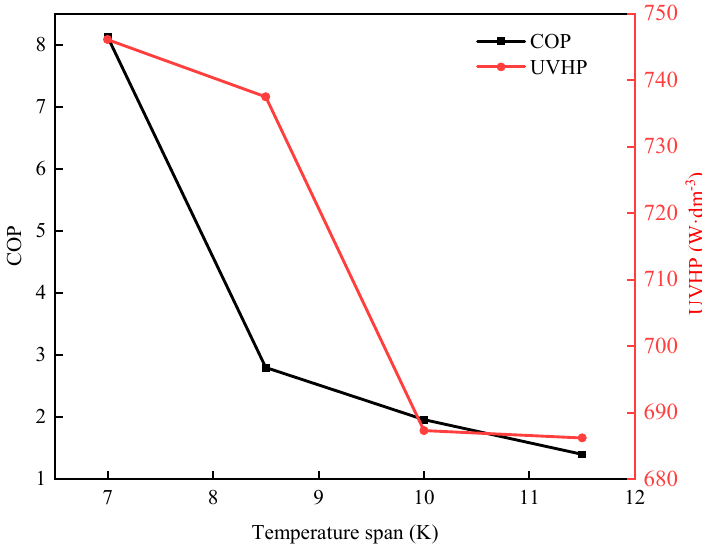
Figure 9. COP and UVHP at different temperature spans. When the temperature span successively increases from 7 K to 11.5 K, the UVHP decreases by 1.16%, 6.8%, and 0.17%, respectively, while COP decreases most when the temperature span changes from 7 K to 8.5 K. COP depends on the relative size between Q h and Q c , while there are two variables in Formula 16 that determined the size of UVHP, i.e., T heat − T h and u f . To analyze the effect of temperature span only, u f was the same for different cycles. Hence, the differential form of Q h can be written as dQ h = C · d ( T heat − T h ) ; C is constant coefficient. The differential form of Q c is dQ c = C (cid:48) · d ( T c − T cold ) ; C (cid:48) is also a constant coefficient. As the temperature of the cold heat exchanger decreased equally, T cold varied with T c and then caused T heat − T h to change because the fluid’s temperature at the end of the previous cycle always affected the next cycle. Figure 10 presents the temperature variation trend of the fluid at four different cases shown in Table 3. Taking Case 4 as an example, the red and blue shadows in the figure represent the integral regions of Q h and Q c , respectively. After the cycle tended to be stable, T heat − T h and T c − T cold decreased with the increase in temperature span, thus leading to the decrease in both heat production Q h and cooling capacity Q c . However, Q c decreases more as COP decreases with the increase in temperature span.